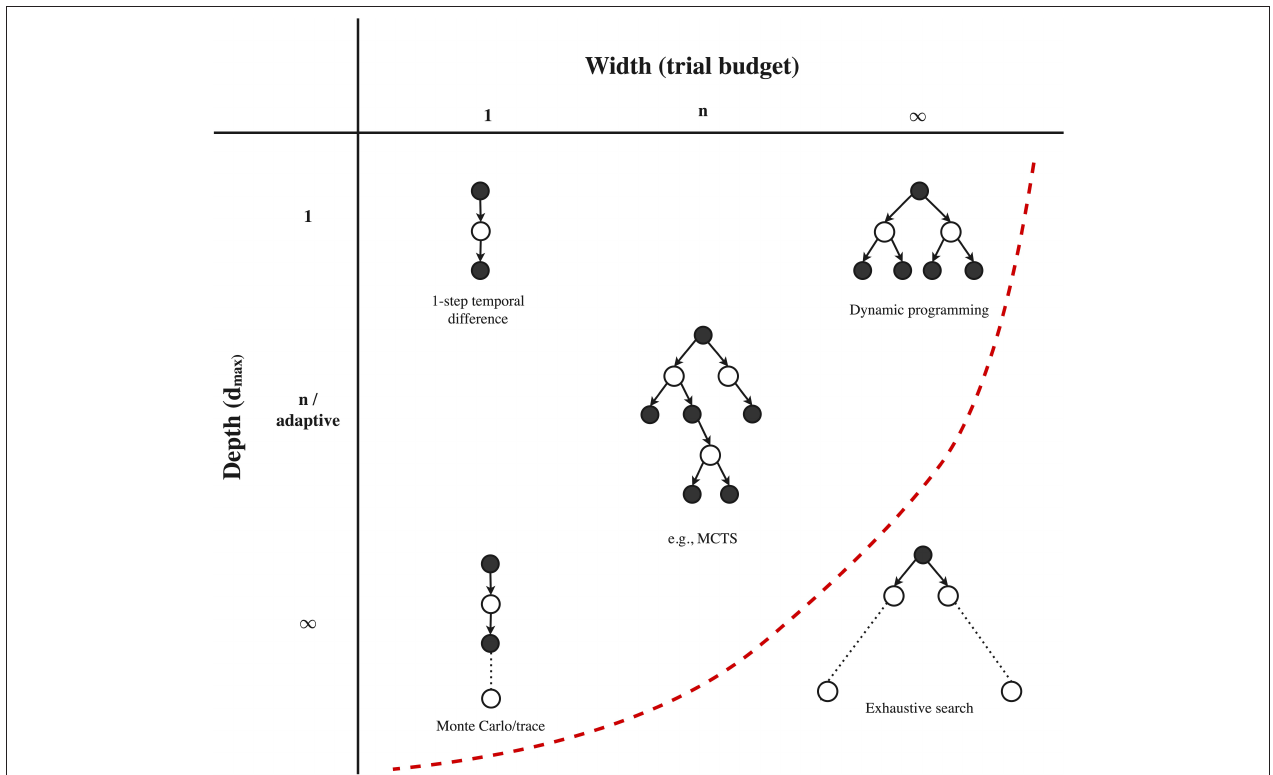
FIGURE 4 | Possible combinations of width (trial budget) and depth ( d max ) per trial from a root state. Practical algorithms reside somewhere left of the left dotted line, since full with combined with full depth (exhaustive search) is not feasible in larger problems. Figure extended from Sutton and Barto